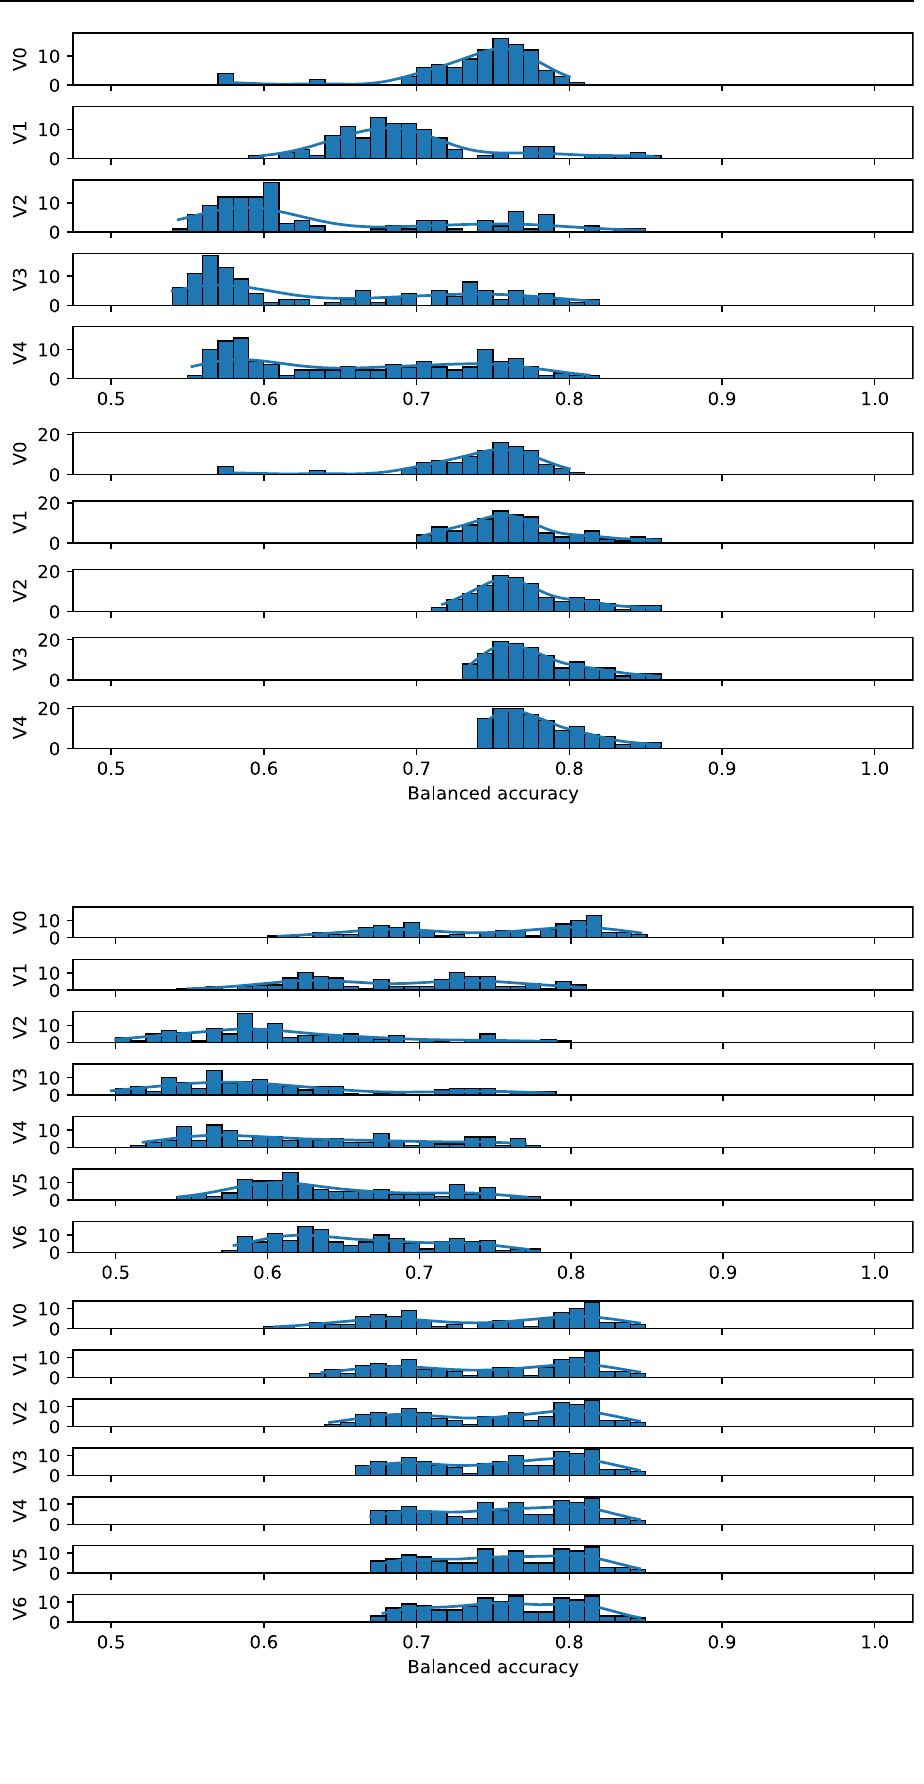
Fig. 4 Histogram of the bal- anced accuracy of trees in the DR dataset. Update metrics on top, no update below